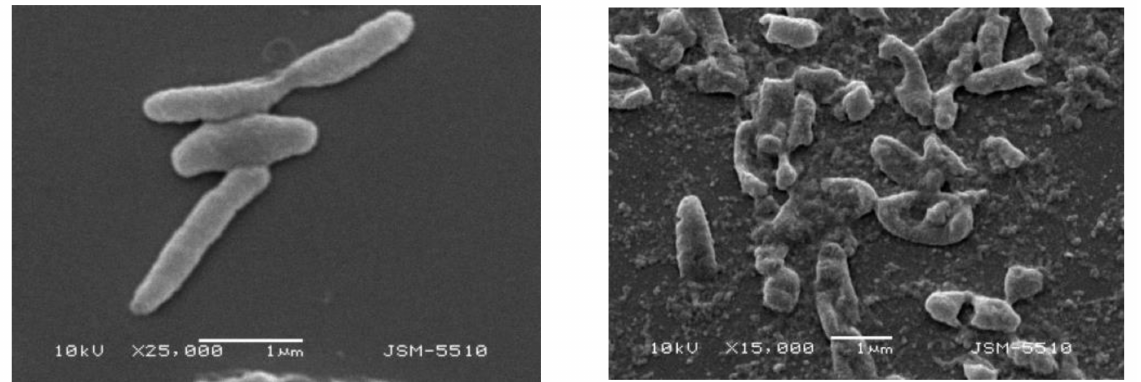
Figure 5. SEM micrographs of Pseudomonas aureofaciens AP-9 ( × 25,000 and 15,000, scanning electron microscope JEOL JSM 5510): ( left )—control; ( right )—plasma-treated sample with a duration of 30